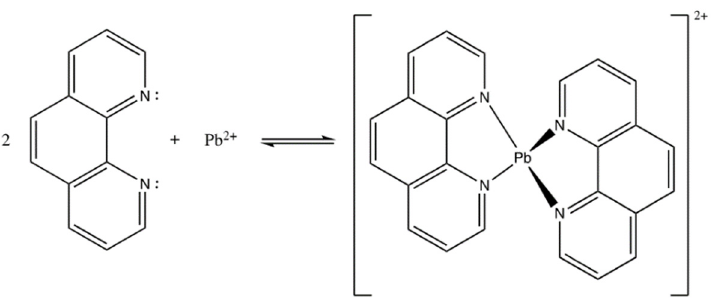
Figure 2. Interaction between 1,10-phenanthroline and Pb 2+ forming phenanthroline-Pb complex.